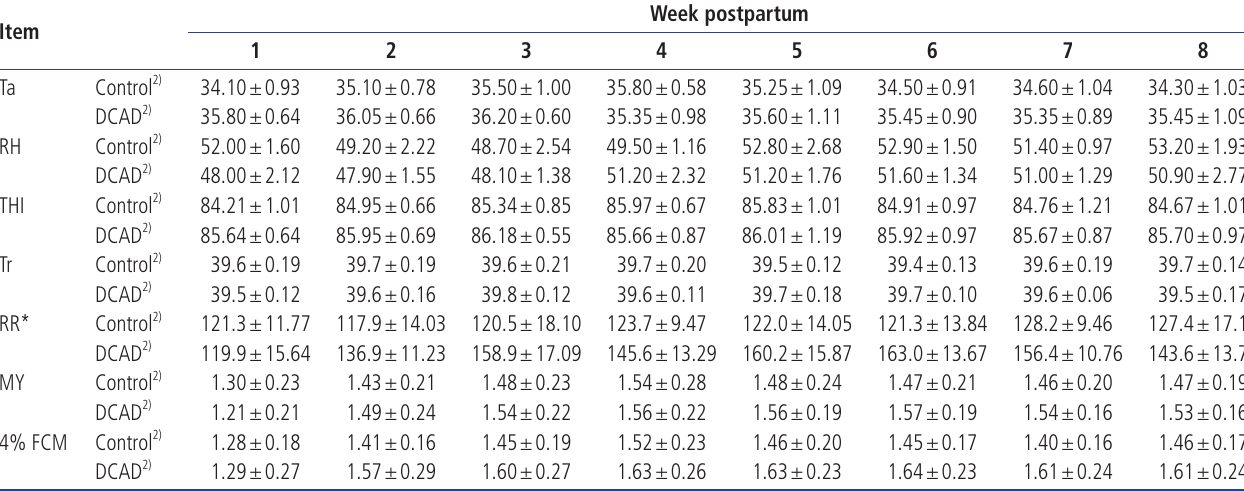
Table 2. The environmental conditions and animal responses from the present experiment 1)